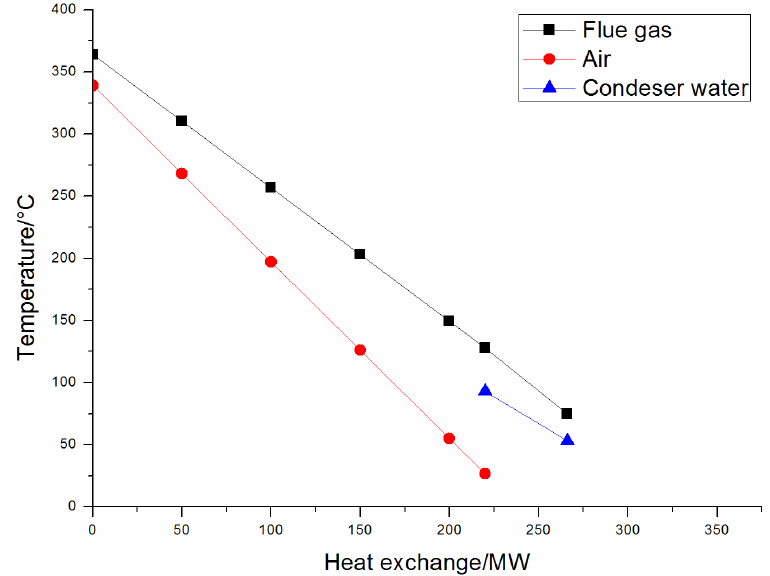
Figure 2. Comprehensive heat transfer curve of the conventional system.